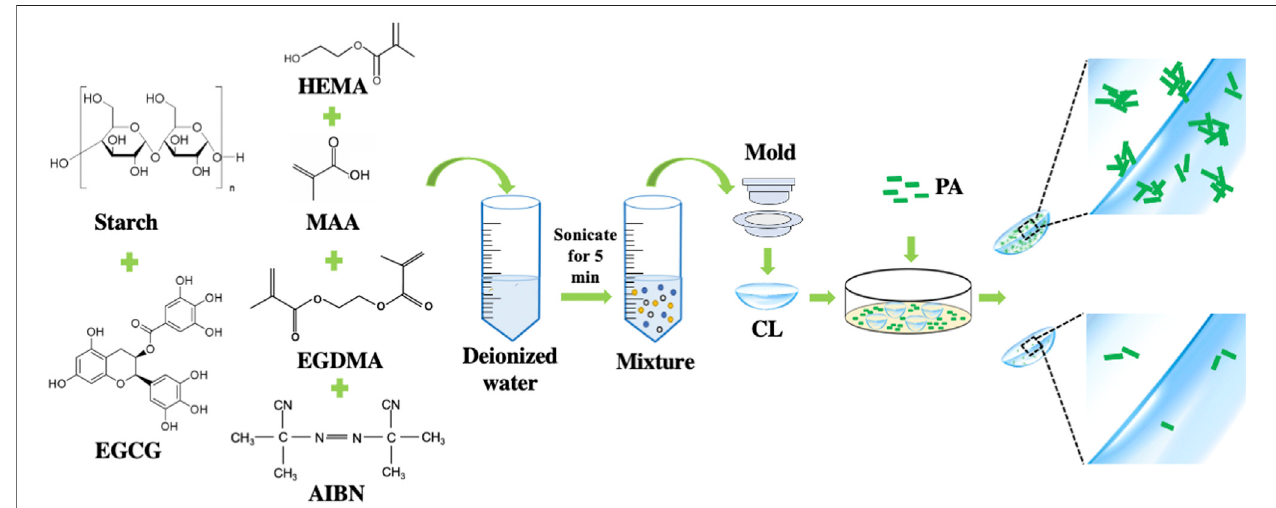
FIGURE 1 | Schematic preparation of epigallocatechin gallate loaded starch hydrogel/contact lens composites.